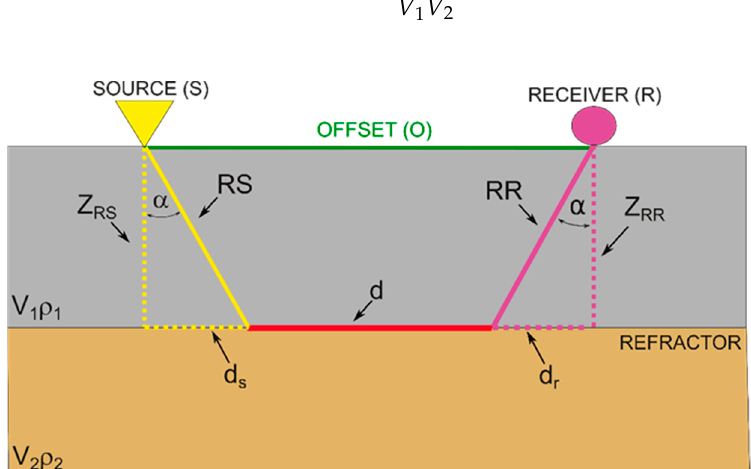
Figure 5. Delay Time Analysis method scheme: O—the distance from source to receiver in a straight line, V 1 , V 2 —the velocity of layer 1 and layer 1 with the assumption V 1 < V 2 , ρ 1, ρ 2—the volumetric density of layer 1 and layer 2, RS—true ray path from source to refractor, RR true ray path from receiver to refractor, Z RS , and Z RR —vertical component of RS and RR, d S and d R —horizontal component of RS and RR, d—distance travelled with refractor velocity, α —refraction angle.